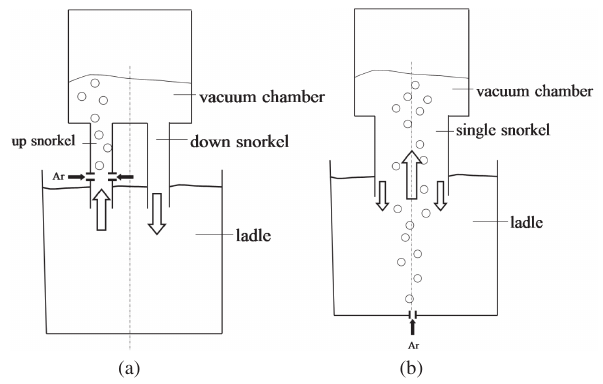
Figure 1: Schematic diagrams of RH degasser and SSF degasser.